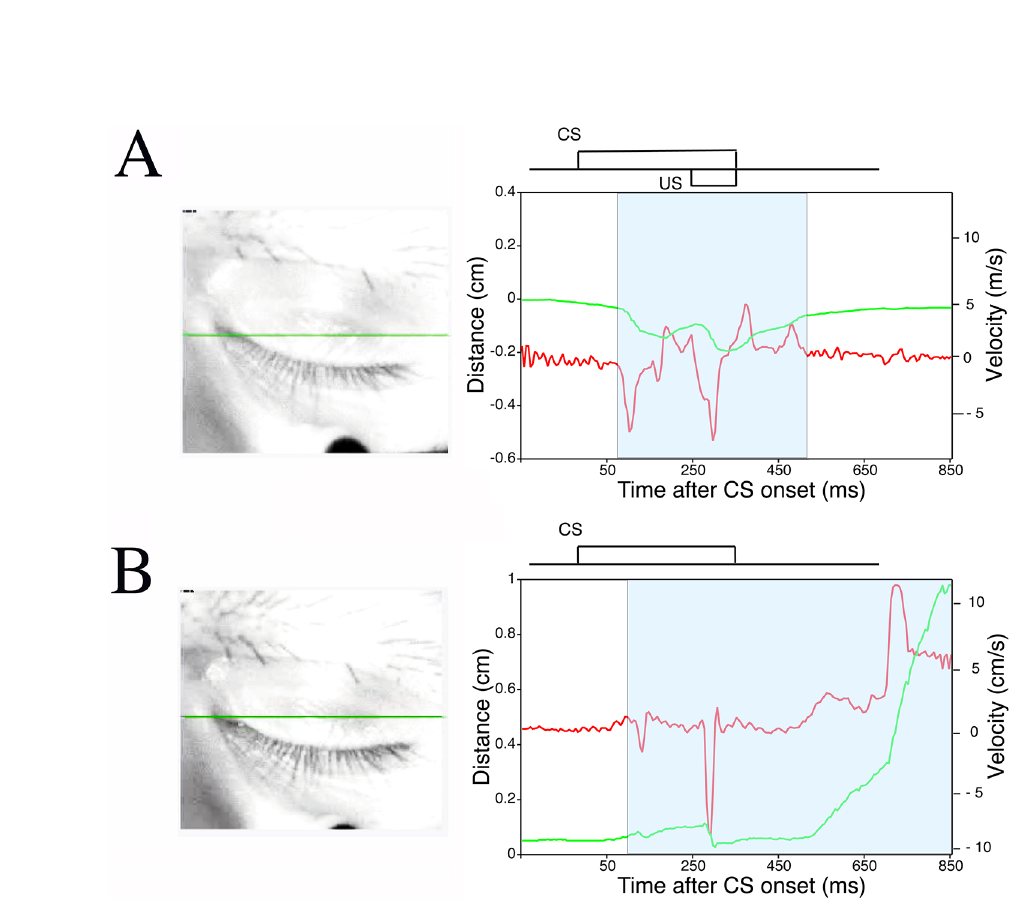
Fig 7. A preliminary study of CR expression during eyes-closed periods. Examples of CR expression during eyes-closed periods in a CS-US paired trial (A) and CS-only trial (B). Monkeys in light sleep often exhibit delay CRs despite their eyelids being completely closed (S1 and S2 Videos). Note that in such cases, the monkeys exhibit more downward movement of the upper eyelid than is needed to close the eye, resulting in a negative distance measurement. A schematic representation of the CS and US is inset above the plots of eyelid movement and speed. Green and red lines show the position and velocity of the upper eyelid, respectively. The red arrow indicates robust CRs between CS and US